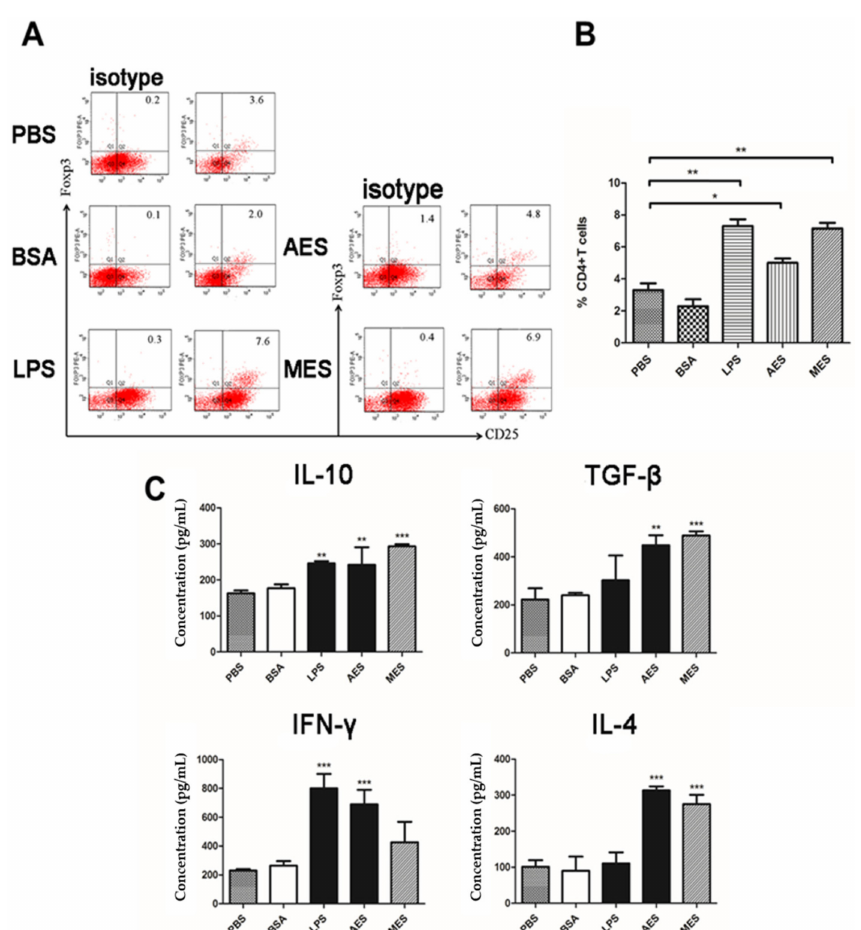
Figure 7. Ts ES-primed BMDCs upregulated Foxp3 + CD4 + CD25 + T cells populations and Treg